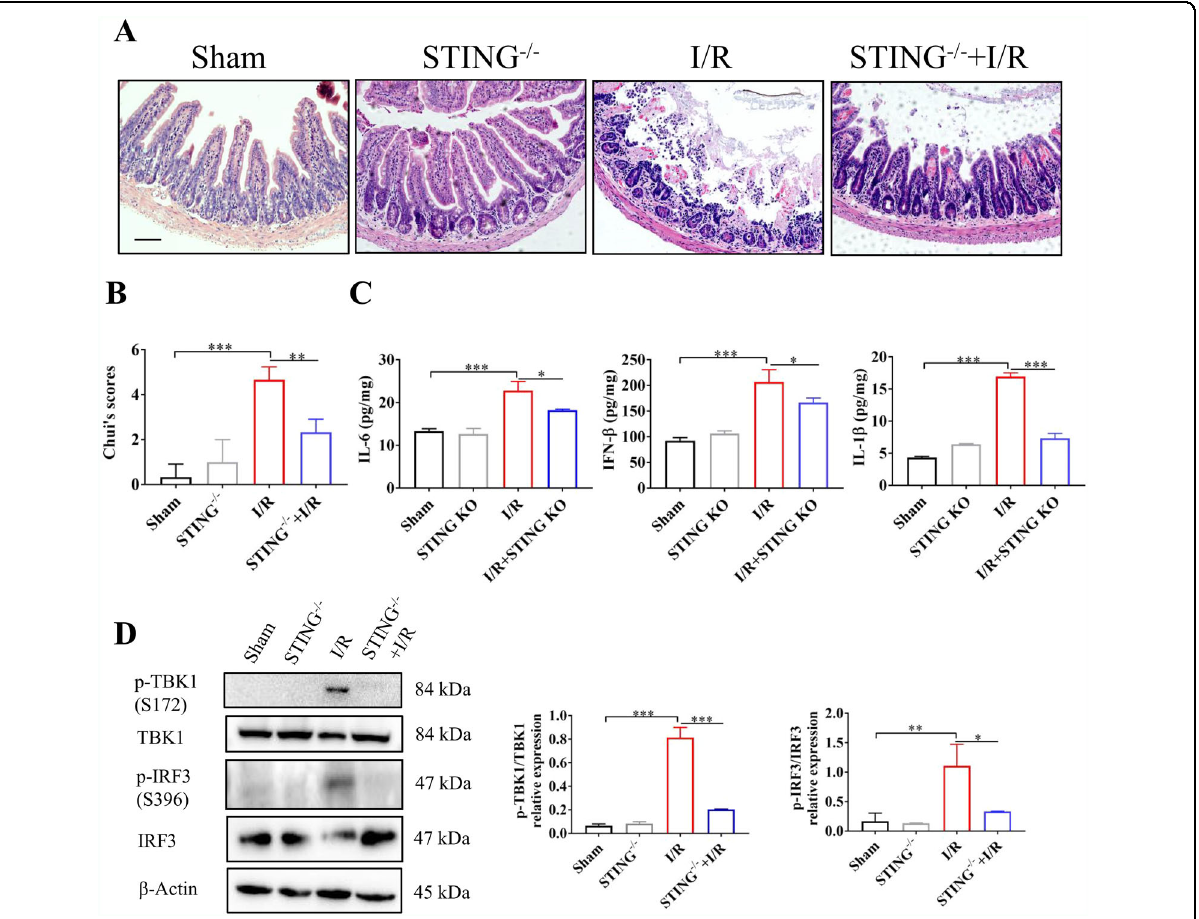
Fig. 5 STING knockout alleviates intestinal I/R injury. (A) Photomicrographs of intestine in wild-type mice and STING knockout following intestinal I/R injury. (B) Intestinal injury was assessed by Chui ’ s score. (C) IFN- β 、 IL-6 and IL-1 β in intestinal tissue were analyzed by ELISA. (D) STING signaling was analyzed by western blot. Scale bars = 50 μ m. Data were showed as the mean ± SD. * P < 0.05, ** P < 0.01, *** P <